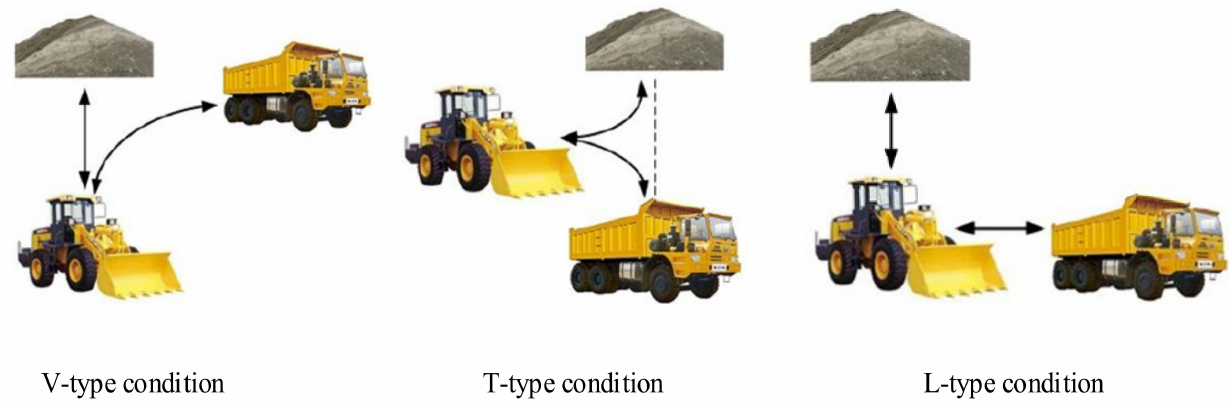
Figure 1. Typical working conditions of loaders.